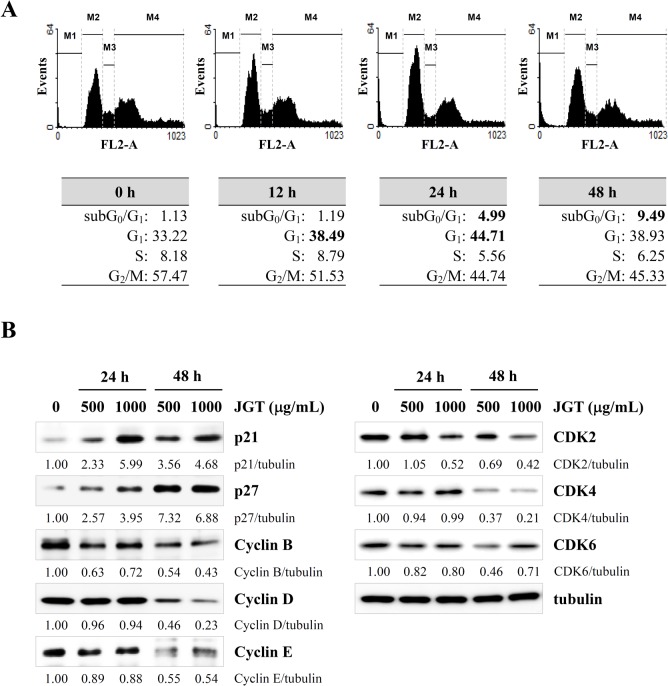
JGT induces cell cycle arrest in the G1 phase.
(A) HT1080 cells were incubated with 1000 μg/mL JGT for 12, 24, and 48 h, and cell cycle distribution was analyzed after PI staining. (B) The levels of cell cycle-related proteins in JGT-treated cells were determined by Western blotting. The band intensities relative to those of untreated cells were calculated using ImageJ software after normalization to tubulin expression. Data are representative of three independent experiments.